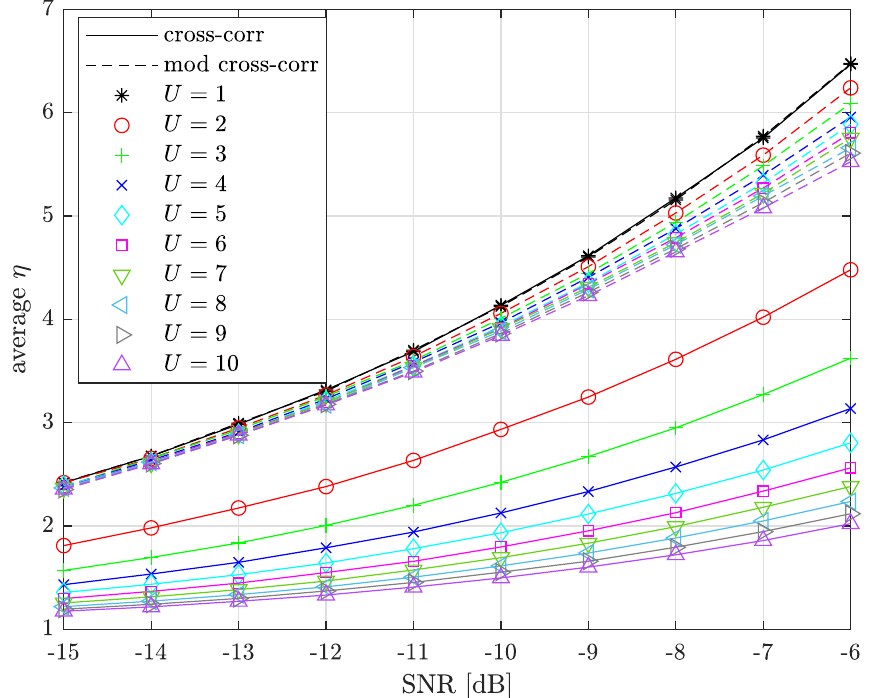
Figure 9. U sensitivity comparison between the legacy and the modified cross-correlation schemes, SF =